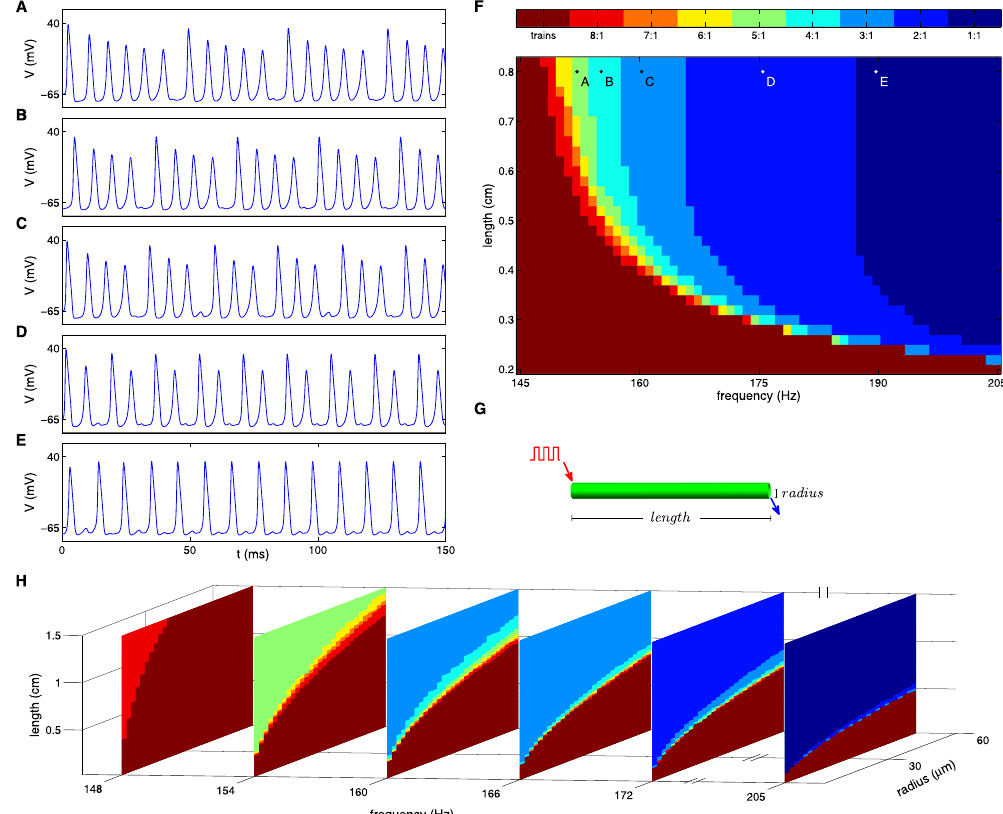
Figure 2. Responses to current stimuli in the studied phase space for unbranched axons. ( A – E ) Time dynamics of propagating signals generated with parameters indicated in phase plane diagram ( F ). The colors in the phase plane diagram represent different firing patterns as shown in the color key. The axonal radius used to construct the phase plane is 10 µ m, and the signals were measured as schematically shown in ( G ) by a blue arrow. ( H ) Z-stack phase plane diagrams of axonal radius vs. axonal length are shown for six stimulus frequencies. Same color code as in ( F